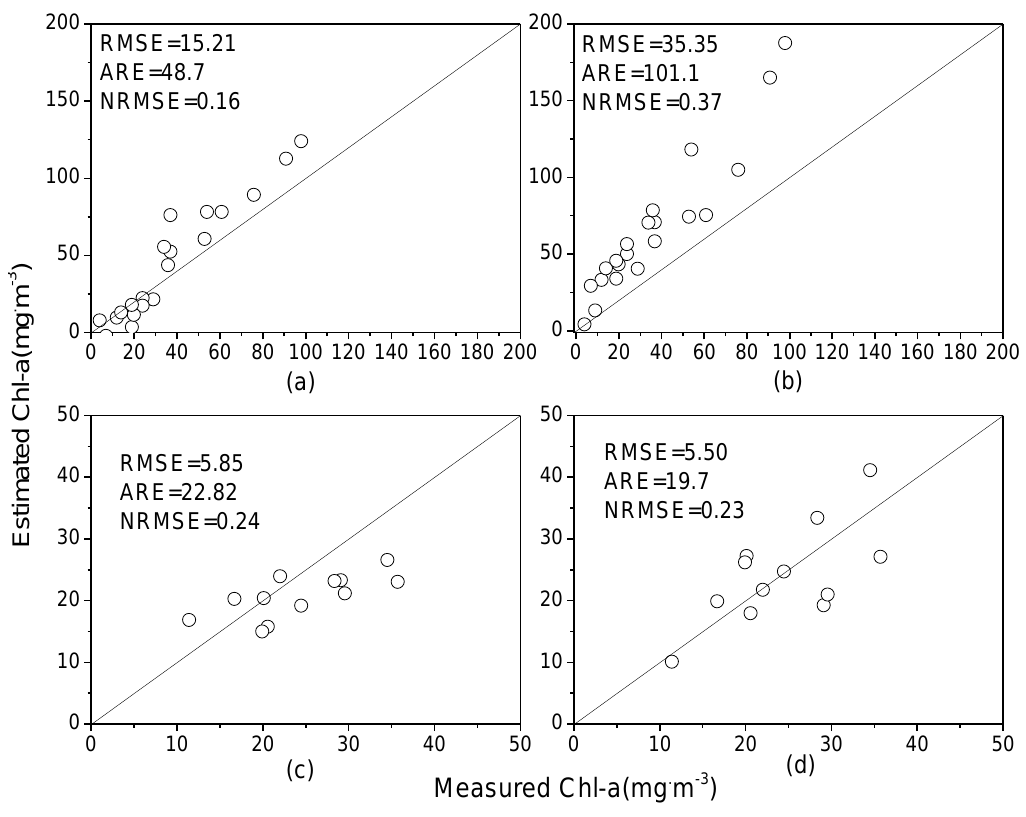
Figure 5. Validation of ( a ) first-order derivative model using data from 2005, ( b ) second-order derivative model using data from 2005, ( c ) first-order derivative model using data from 2011, and ( d ) second-order derivative model using data from